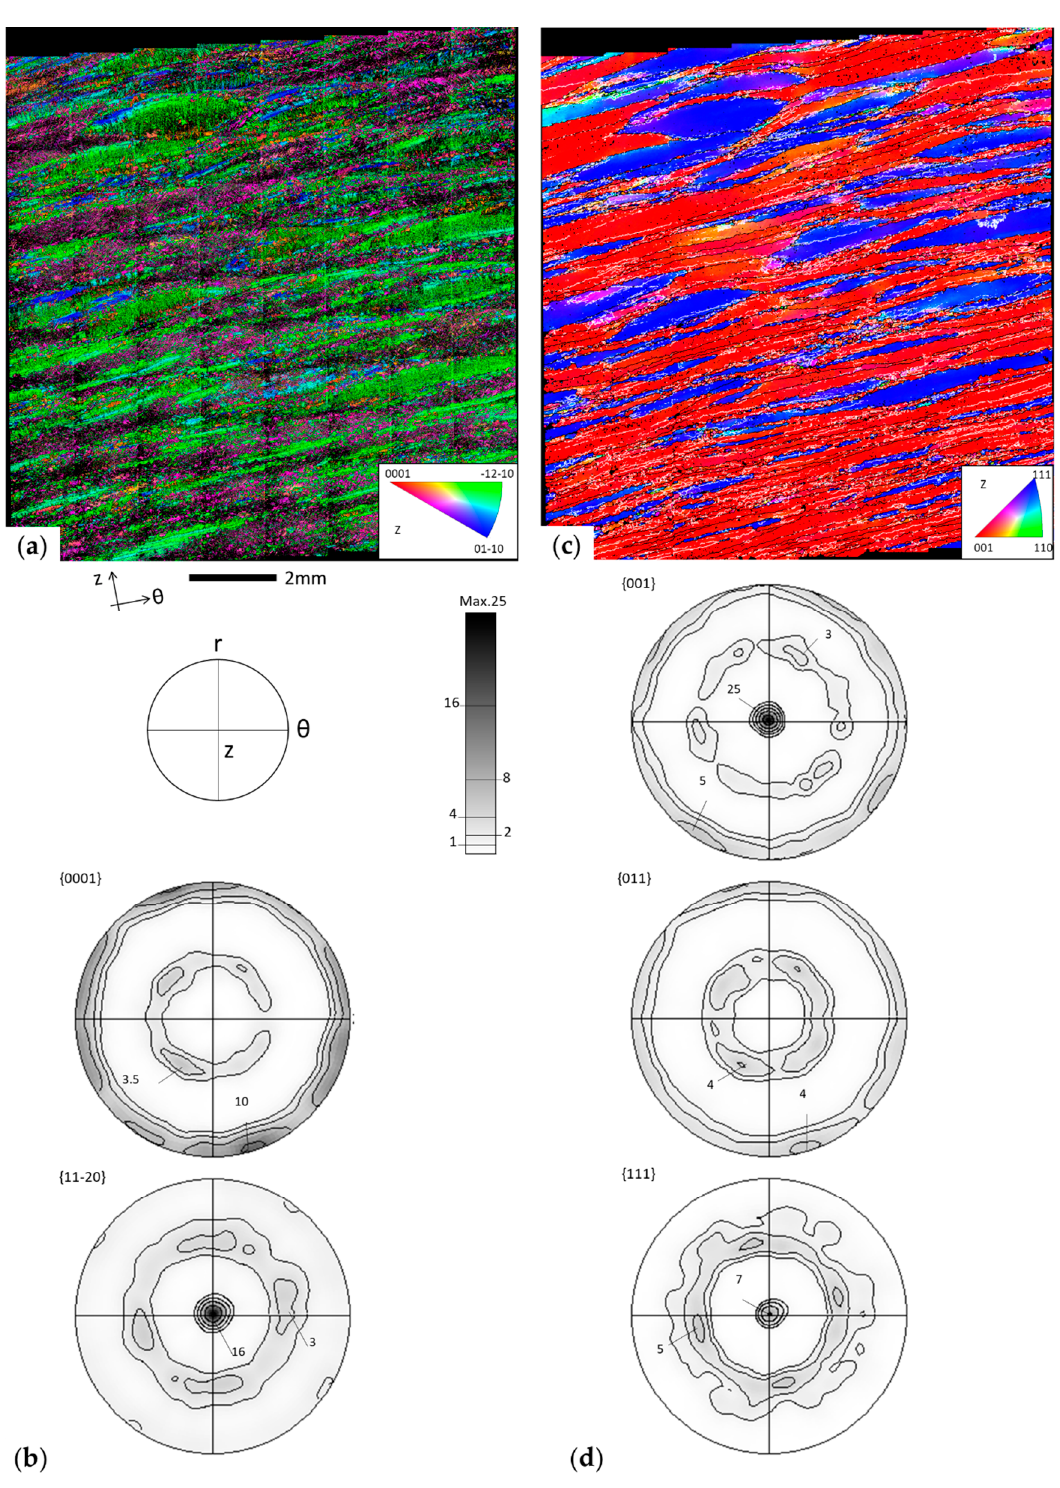
Figure 2. Microtexture and Texture of the disk: maps ( a ) IPF // Z EBSD map of the measured α phase; ( b ) Corresponding texture; ( c ) IPF // Z EBSD map of the reconstructed β phase (High